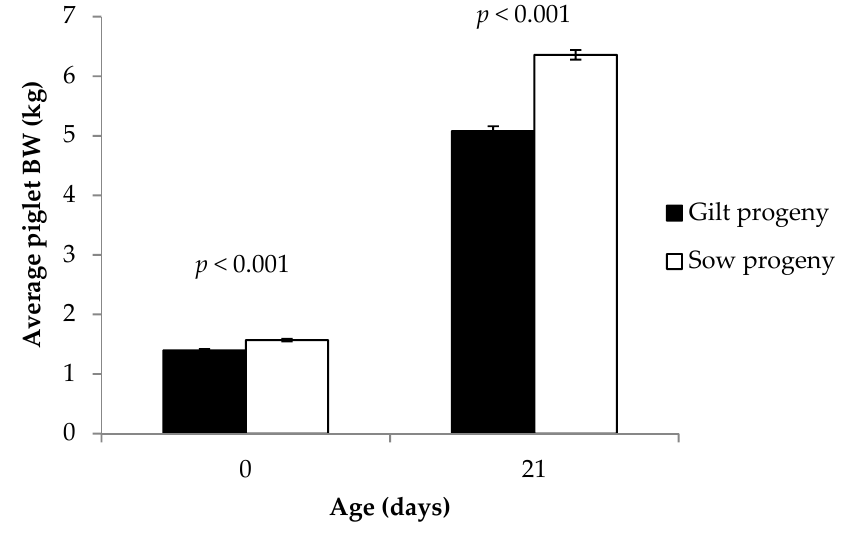
Figure 2. Effect of dam parity (primiparous versus multiparous; gilt versus sow progeny) on average piglet body weight (BW) at 0 and 21 days of age.